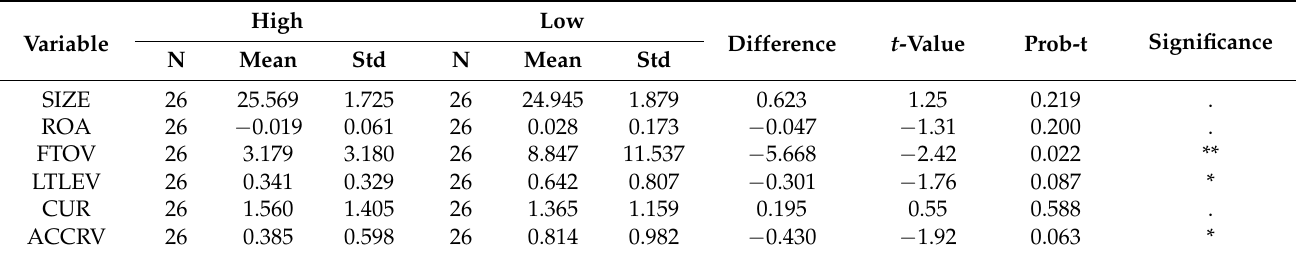
Table 6. The mean difference of TF/IDF of LG between high (1,2) and low (4,5) quintile.